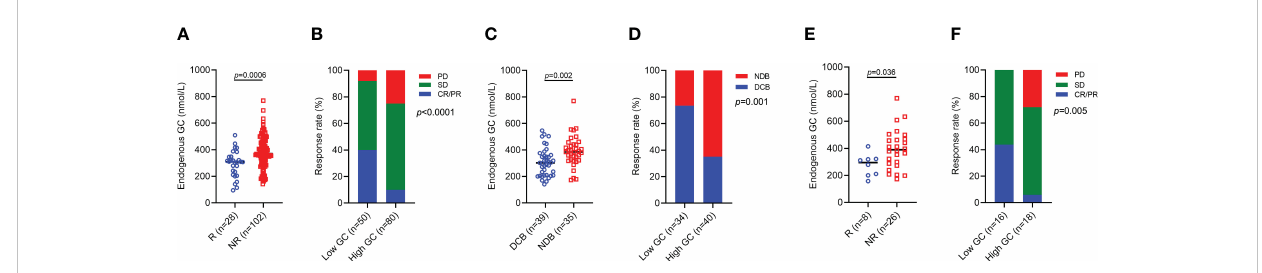
FIGURE 2 ORR and DCB for advanced cancer patients with high baseline endogenous GC levels versus low endogenous GC levels. (A) Comparing the baseline endogenous GC levels in all advanced cancer patients with response (R, n=28) and patients with no response (NR, n=102). (B) The rate of CR/PR (ORR), SD, PD in all advanced patients with high (n=80) or low (n=50) baseline endogenous GC levels. (C) Comparing the baseline endogenous GC levels in all advanced patients with DCB (n=39) and NDB (n=35). (D) The rate of DCB in all advanced patients with high (n=40) or low (n=34) endogenous GC levels. (E) Comparing the baseline endogenous GC levels in advanced gastric cancer patients with response (R, n=8) and patients with no response (NR, n=26). (F) The rate of CR/PR (ORR), SD, PD in all advanced gastric cancer patients with high (n=18) or low (n=16) baseline endogenous GC levels. GC, glucocorticoid; CR, complete response; PR, partial response; ORR, objective response rate; SD, stable disease; PD, progressive disease; DCB, durable clinical bene fi t; NDB, no durable clinical bene fi